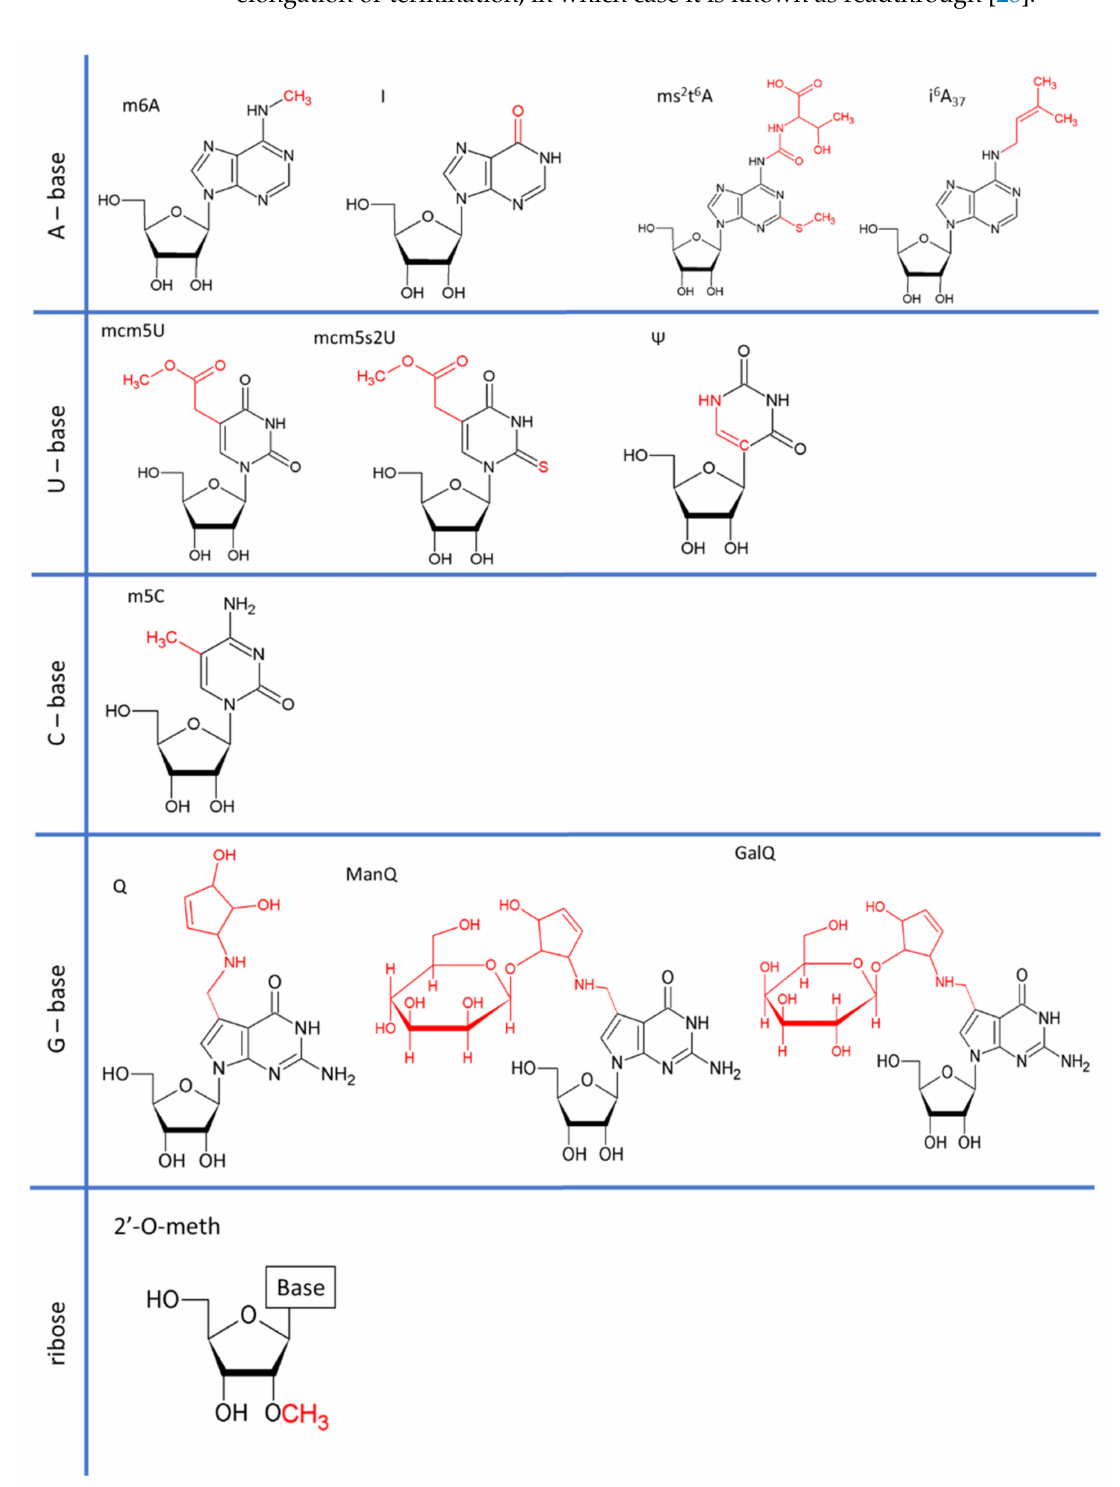
Figure 1. Structure of different RNA modifications discussed in this review. In black: basic structure of the base or ribose concerned. Red: chemical modification. m6A: N6-methyladenosine. I: inosine. ms 2 t 6 A: 2-methylthio-N6- threonylcarbamoyladenosine. I 6 A: N6-isopentenyladenosine. mcm 5 U: 5-methoxycarbonylmethyluridine. mcm 5 s 2 U: 5-methoxycarbonylmethyl-2-thiouridine. Ψ : pseudo-uridine. m5C: 5-methylcytosine. Q: queuosine. ManQ: mannosyl- queuosine. GalQ: galactosyl-queuosine. Nm: 2 (cid:48)